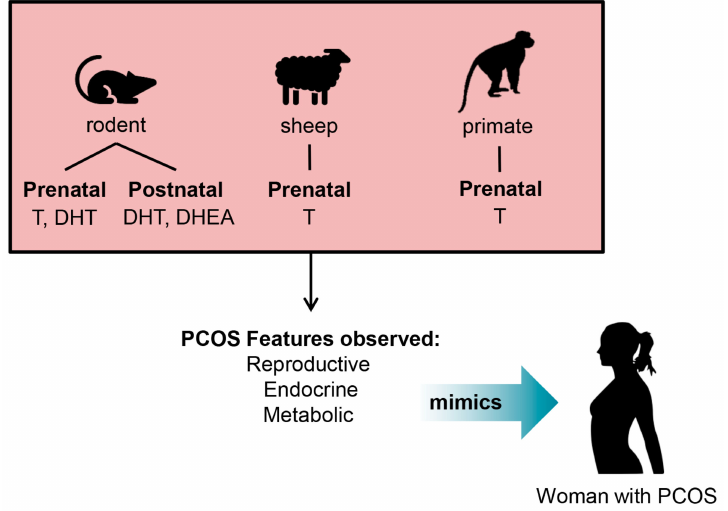
Figure 2. Proposed optimal period for exposure of excess androgens to induce the PCOS phenotype in animal models. Diagram of rodent, sheep and primate PCOS animal models and their prenatal or postnatal period of exposure to androgens to give rise to the PCOS phenotype observed in humans. T = Testosterone DHT = Dihydrotestosterone DHEA =